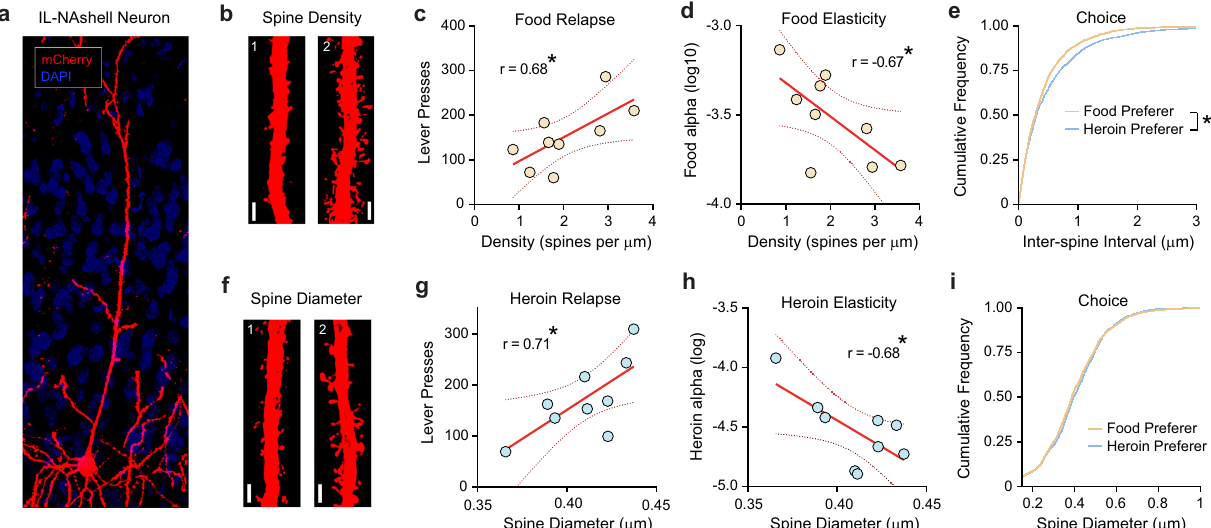
Fig. 6 IL → NAshell spines encode heroin choice and relapse. a Representative micrograph showing mCherry expression in an IL → NAshell neuron (scale bar = 20 µ m). b Representative segments with (left) lowest and (right) highest spine density (scale bar = 3 µ m). Data were obtained from four dendritic segments in nine rats. c IL-NAshell spine density positively correlates with food relapse (Pearson ’ s r = 0.68, p = 0.04) and d negatively correlates with food alpha (Pearson ’ s r = − 0.67, p = 0.04). e Cumulative frequency distribution showing lower inter-spine interval is associated with food preference (two-tailed two-sample Kolmogorov – Smirnov test, KS2 = 0.07, p = 1.29 × 10 − 5 ). f Representative segments showing (left) smallest and (right) largest spine head diameters from IL → NAshell neurons (scale bar = 3 µ m). Data were obtained from four dendritic segments in nine rats. g Spine head diameter positively correlates with heroin relapse (Pearson ’ s r = 0.71, p = 0.03) and h negatively correlates with heroin alpha (Pearson ’ s r = − 0.68, p = 0.04). i spine head diameter does not differ between heroin and food preferring rats. Total n = 9 rats (food preferer n = 4, heroin preferer n = 5). * p < 0.05 signi fi cant correlation ( c , d , g , h ) or comparing between food and heroin preference ( e ).